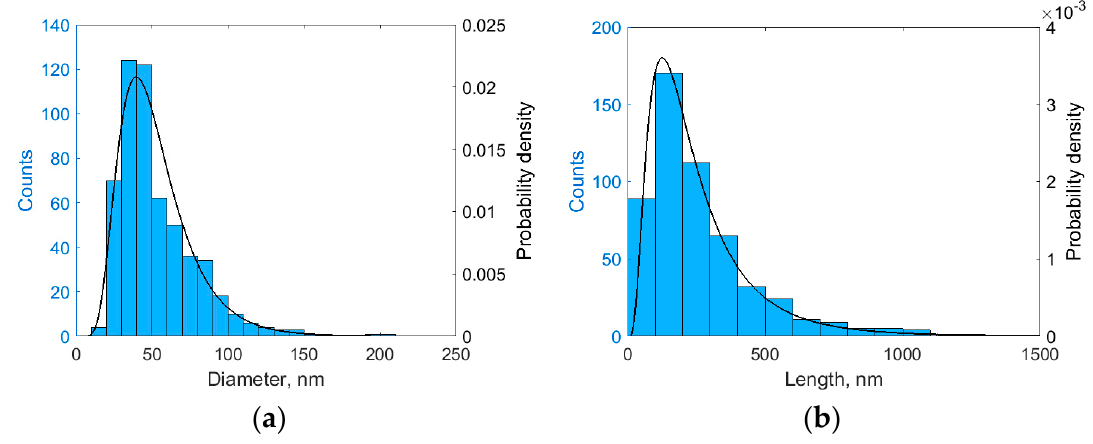
Figure 4. ( a ) Diameter distribution of halloysite nanotubes; ( b ) Length distribution of halloysite nanotubes.